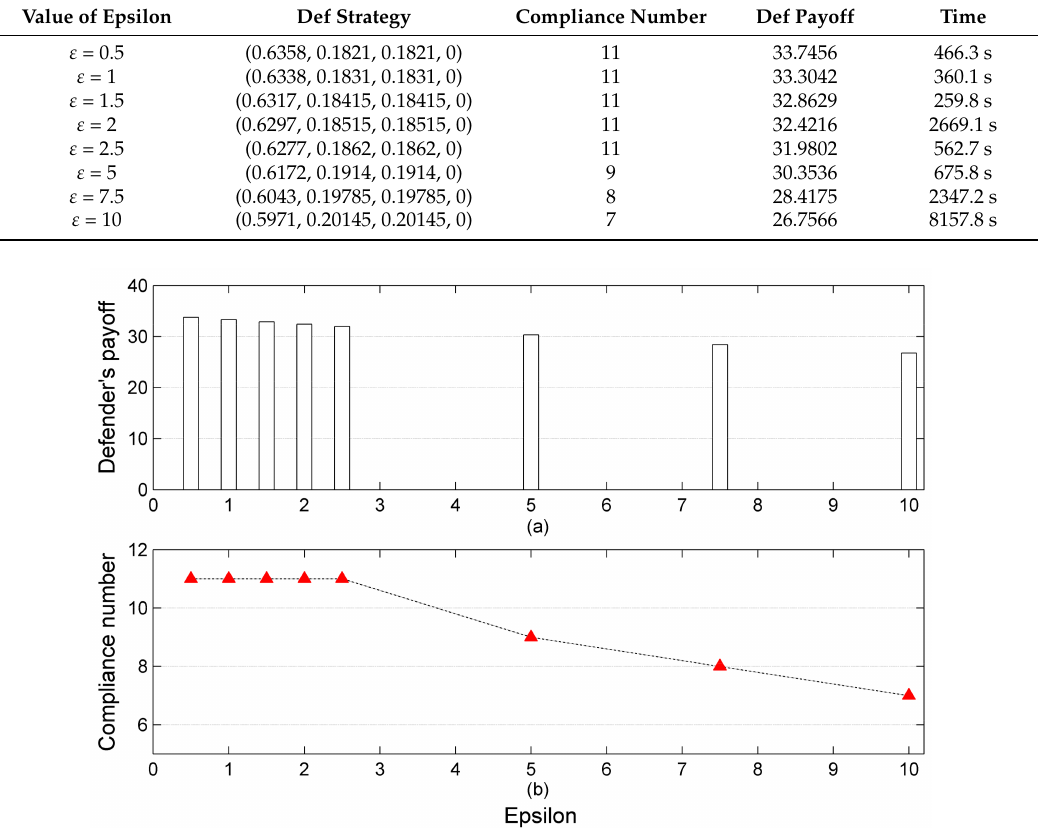
Figure 4. Defender’s payoff and compliance number under different rationality levels of attackers (( a ) denotes the defender’s payoff when the value of epsilon increases while ( b ) denotes the compliance number in the same